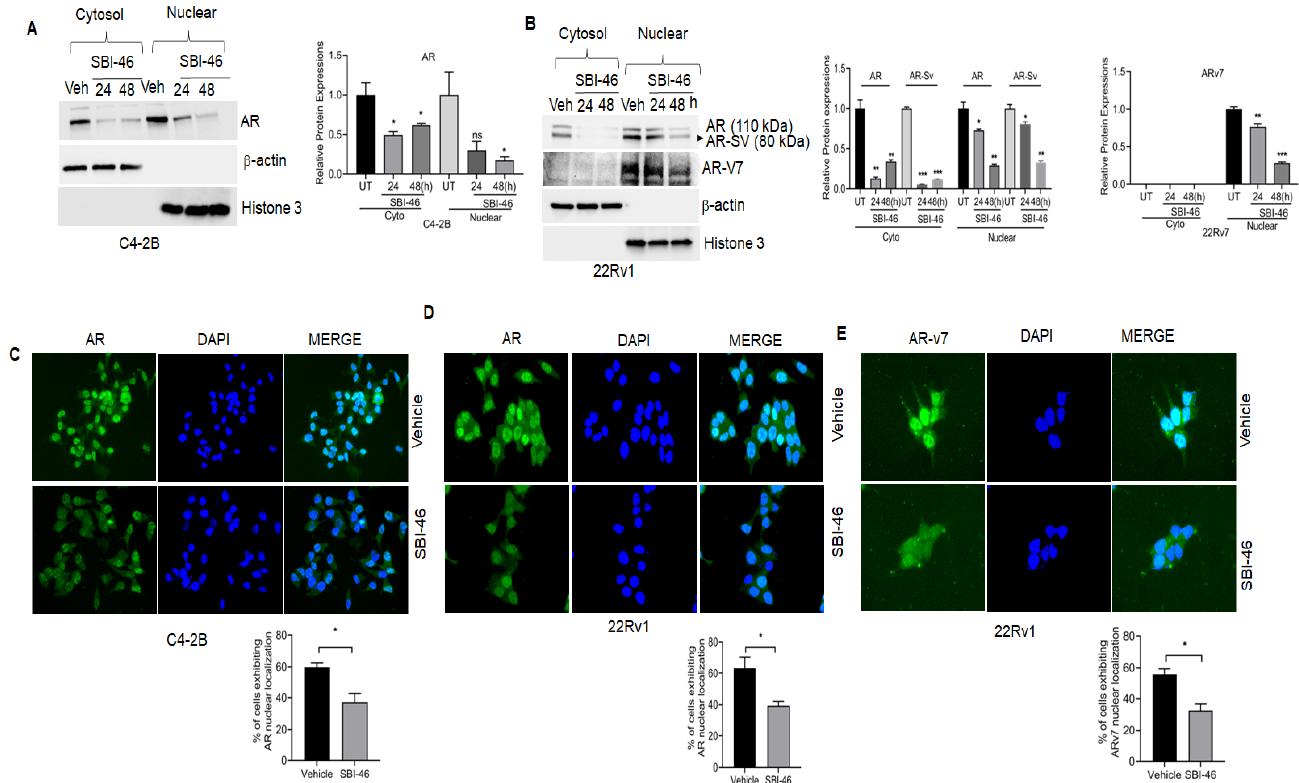
Figure 2. SBI-46 inhibited cytoplasmic and nuclear expressions of AR and AR-V7. ( A , B ) Western blot analysis of AR and AR-V7 expression in cytoplasmic and nuclear extracts of C4-2B and 22RV-1 cells after treatment with SBI-46. Densitometry analysis was performed with ImageJ software for the immunoblots. The p -values corresponding to various symbols used are: ns, not significant ( p > 0.05); * p ≤ 0.05; ** p ≤ 0.01 and *** p ≤ 0.001. ( C – E ) Representative fluorescent images of AR and ARv7 in C4-2B and 22RV-1 cells 24 h after treatment with vehicle or SBI-46. Quantitative data are presented as mean ± SD. The uncropped blots are shown in the Supplemental Materials.